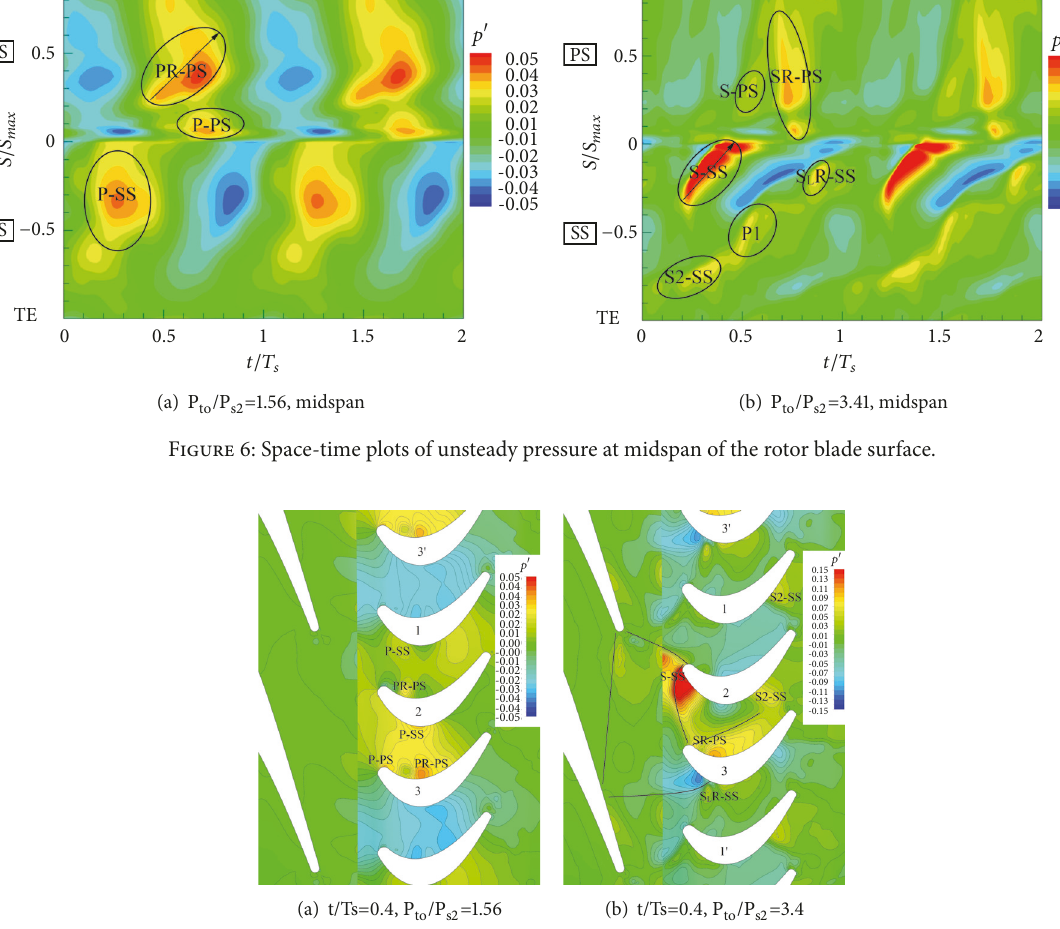
chord from the leading edge (0) along suction (negative half) and pressure (positive half) side to the trailing edge (1) at